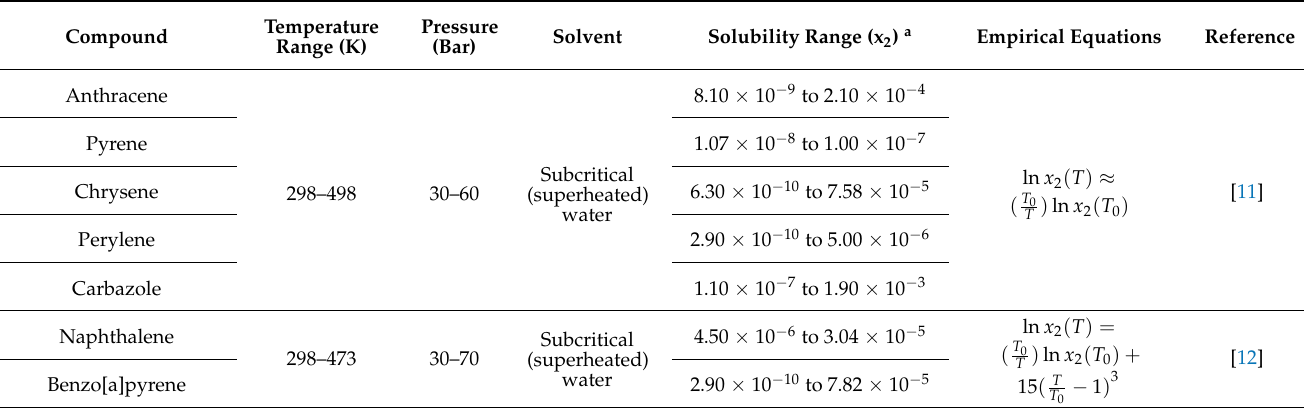
Table 1. The solubilities of polycyclic aromatics and derivatives in subcritical